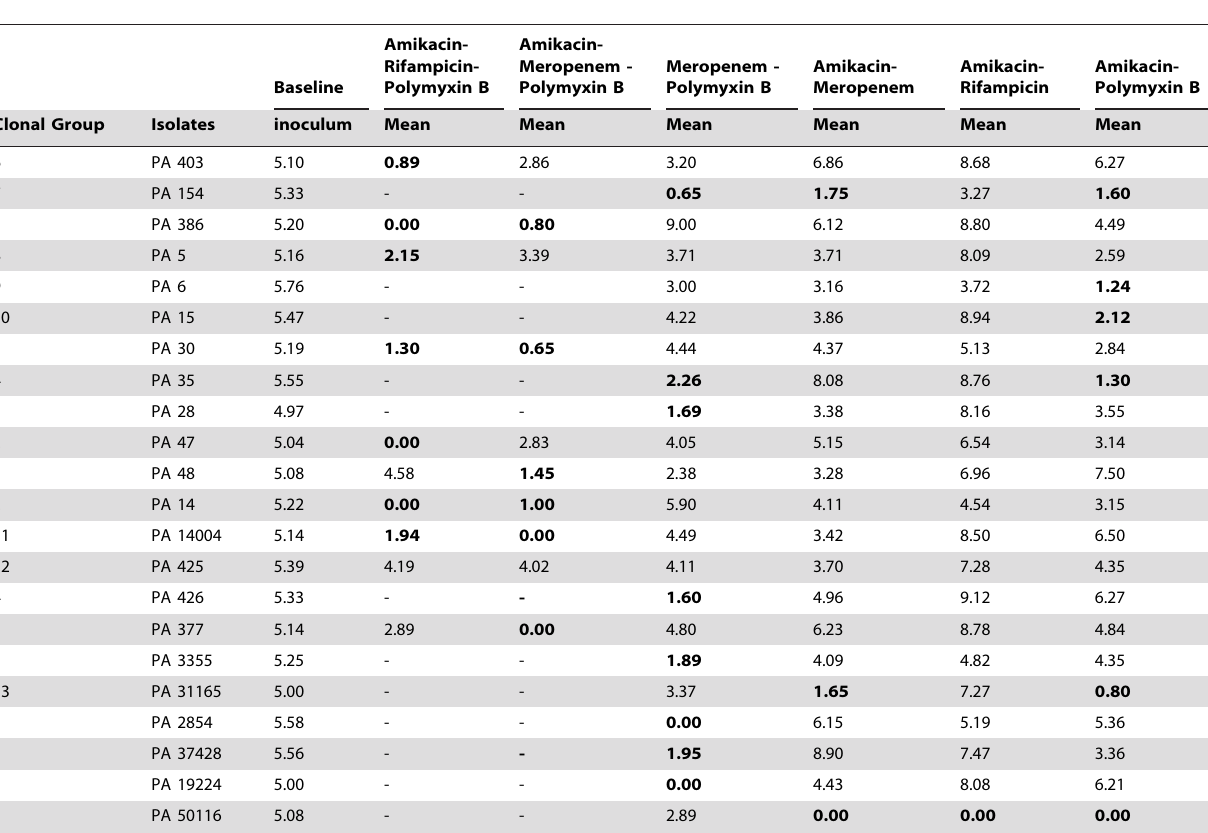
Table 2. 24 hour bacteria burden (log 10 CFU/ml) after exposure to two-drug & three-drug combinations.